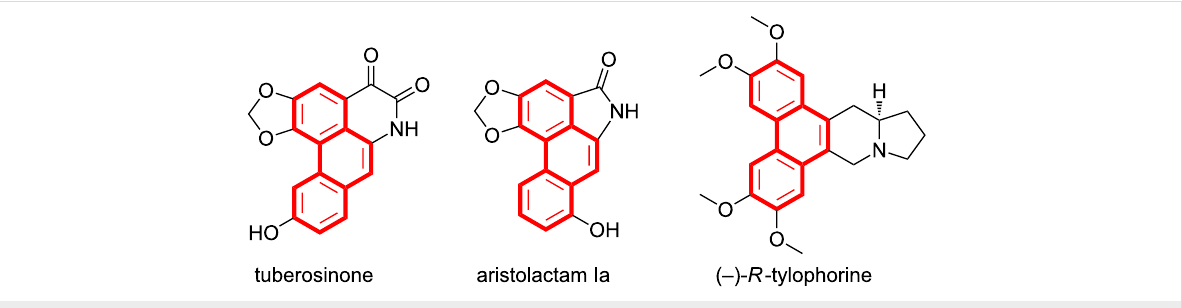
Figure 1: Representative natural products containing a phenanthrene moiety.